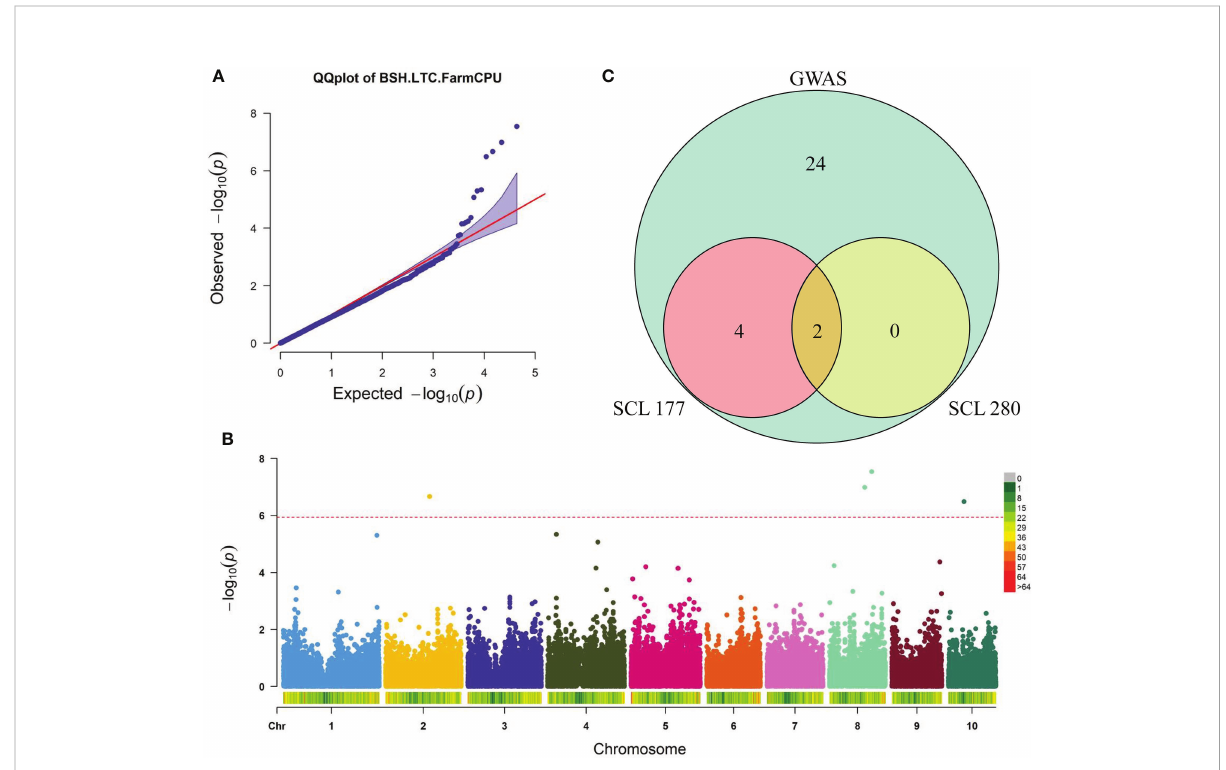
FIGURE 2 Combined genome-wide association study (GWAS) and transcriptome data revealing potential causal genes of maize tolerance to Pb stress. (A, B) Quantile-quantile (Q-Q) plot (A) and Manhattan plot (B) of the GWAS for BSH-LTC by the FarmCPU model. BSH, root bushiness; LTC, lead-tolerance coef fi cient. The dashed red line shows the signi fi cance threshold (2.01×10 -6 ) (C) Wayne diagram displaying the Pb treatment- responsive genes among 30 candidate genes identi fi ed by GWAS. SCL177, a Pb-sensitive maize line; SCL280, a Pb-tolerant maize